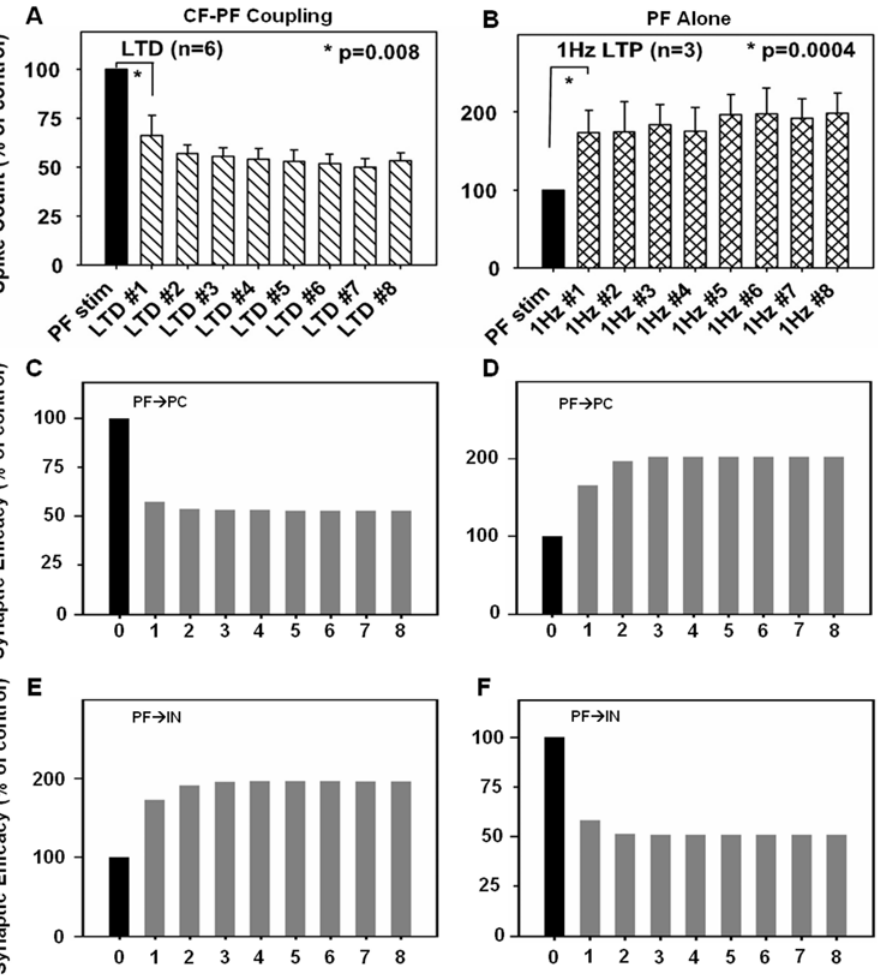
Figure 4. Simulation of changes in synaptic efficacy. A. Induction of LTD from Lev-Ram et al. [40]. Eight rounds of co-stimulation of CF and PF at 1 Hz for 30 seconds caused depression at PF R PC synapse leading to a decrease in spike count (an indirect measure of synaptic efficacy). B. Induction of LTP from Lev-Ram et al. [40]. Stimulation of PF alone induced an increase in spike count (note change of scale). C. Co-stimulation of PF and CF induces LTD in PF R PC synapse, similar to the change in spike count in A. D. Stimulation of PF alone induces LTP in PF R PC synapse, similar to results in B. E. PF-CF co-stimulation induces LTP at PF R IN synapse. F. Stimulating PF alone induces LTD at PF R IN synapses. Note that the same input causes adaptive changes in opposite directions at PF R PC and PF R IN synapses. Data in panels A and B are reproduced with permission from Lev- Ram et al. [40], copyright (2003) National Academy of Sciences, U.S.A.